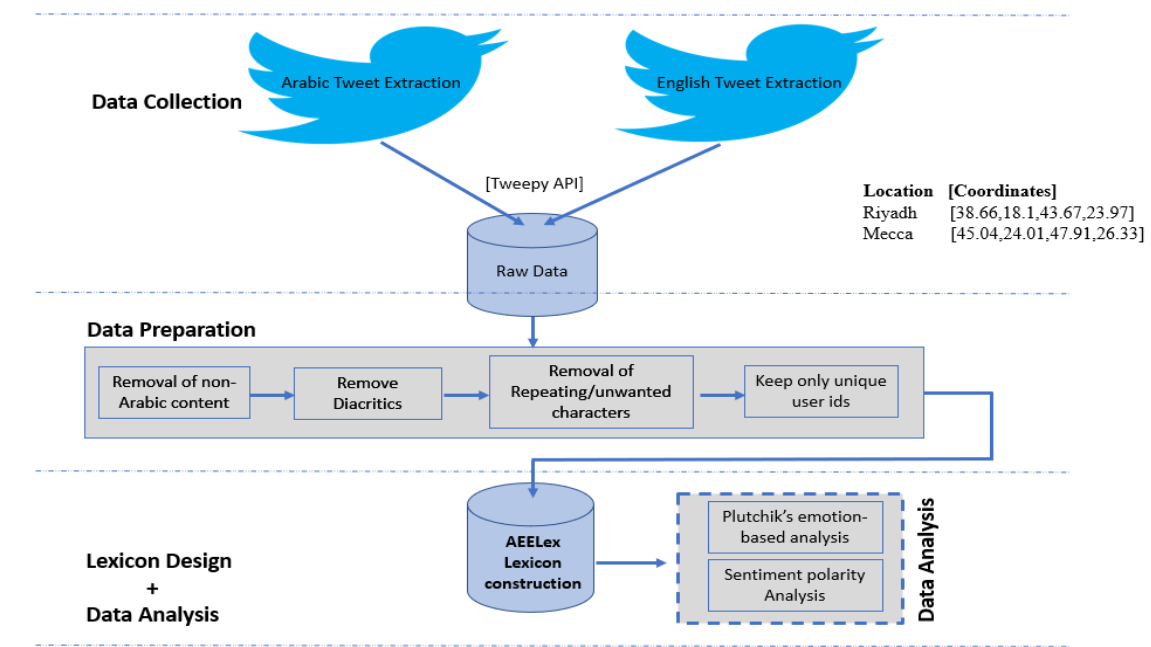
Figure 1. Approach synopsis for studying holy city versus non-holy city. Table 1. Statistics of the data before preprocessing.